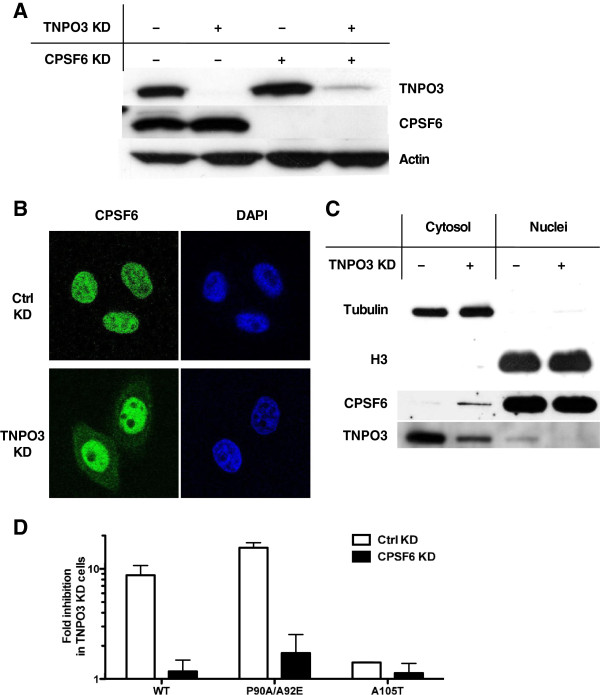
TNPO3 KD inhibits HIV-1 replication by shifting CPSF6 to the cytoplasm. (A) Expression level of CPSF6 and TNPO3 in TZM-bl cells stably transduced with control or CPSF6 KD vectors and transfected with scrambled or TNPO3 specific small interfering RNA (siRNA). Cell lysate was probed in western blots with anti-TNPO3 antibody (upper panel), anti-CPSF6 antibody (middle panel) and anti-β-actin antibody (lower panel). (B) Immuno-fluorescence localization of endogenous CPSF6 (green) in control (Ctrl) KD or TNPO3 KD TZM-bl cells. DAPI staining (blue) was used to mark the nuclear compartment. (C) Cell fractionation to identify the cellular localization of endogenous CPSF6. Expression of tubulin in the cytoplasm and histone 3 (H3) in the nucleus was assessed to verify the fractionation. (D) Stable ctrl KD and CPSF6 KD cells transfected with scrambled or TNPO3 siRNA were challenged with WT or CA mutant HIV-1NL4-3GFP reporter viruses. After 72 hours GFP expression was checked by flow cytometry. The fold inhibition of infectivity due to TNPO3 KD is shown. Data represent one of at least three independent experiments. Error bars represent ± SEM (n = 3).